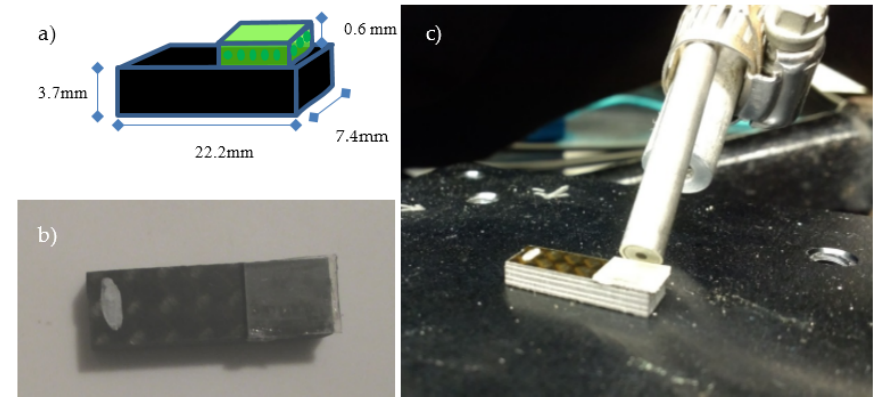
Figure 2. Carbon fiber reinforced epoxy short ‐ beam samples with sensor ‘tabs’ attached. ( a ) Schematic of short ‐ beam sample and tab; ( b ) Top ‐ view image of short ‐ beam sample and tab; ( c ) Side ‐ view of short ‐ beam sample and tab in fluorescent testing position.